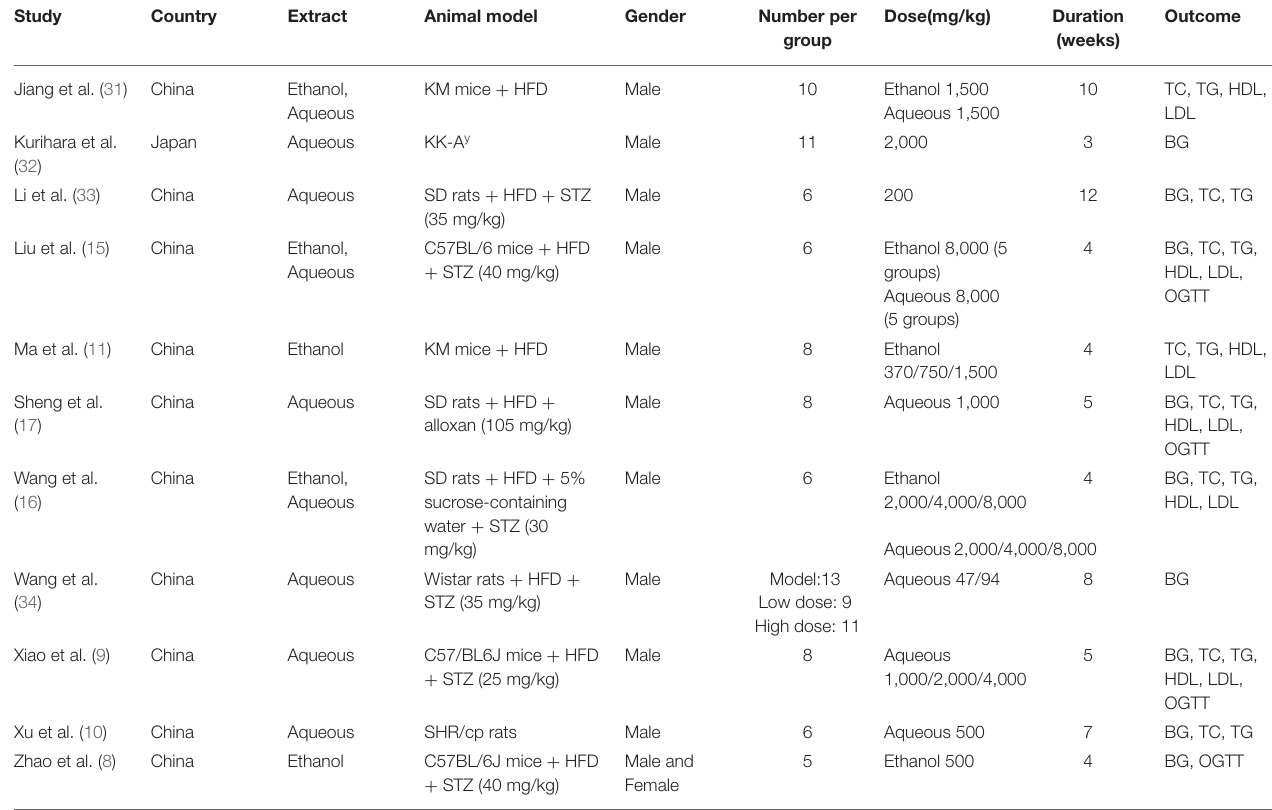
TABLE 1 | Characteristics of articles involved in the